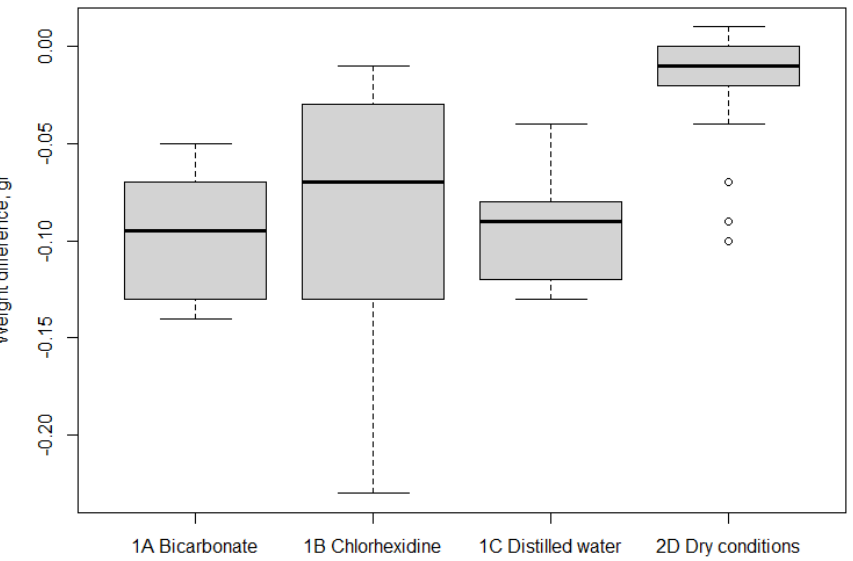
Figure 4. Weight difference in the four groups: bicarbonate (1A), chlorhexidine (1B), distilled water (1C), and dry conditions (2D). Box and whiskers plot.